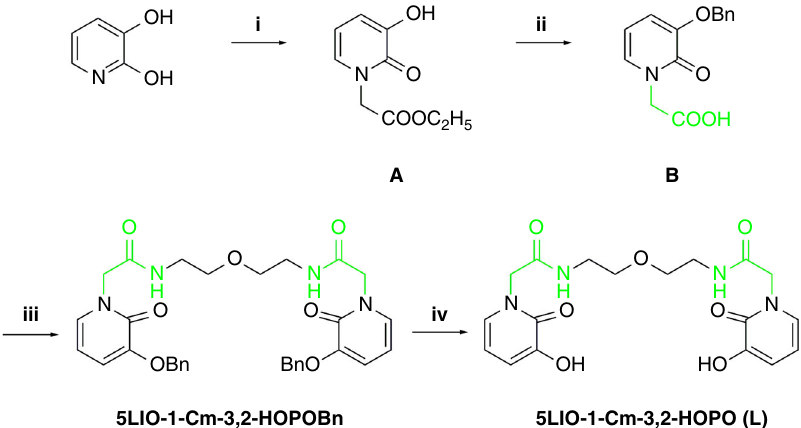
Fig. 1 Synthesis procedure for 5LIO-1-Cm-3,2-HOPO. i: Br-CH 2 COOC 2 H 5 , 150 o C, 24 h; ii: BnCl, NaOH, 80 o C, 12 h; iii: NHS/EDC, 1,5-diamino-3- oxapentane, 30 o C, 12 h; iv: Pd/C, H 2 , 30 o C, 4 h